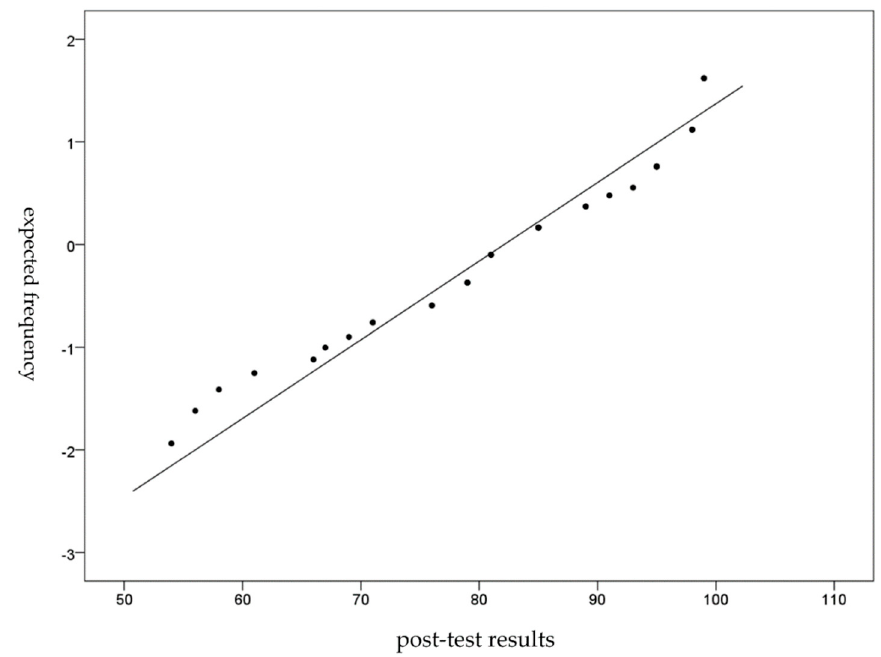
Figure 6. Post-test Q-Q plot.